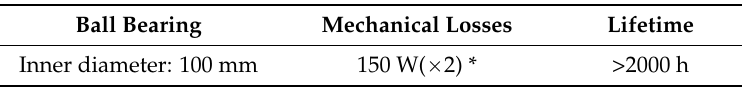
Table 11. Losses in the ball bearing.